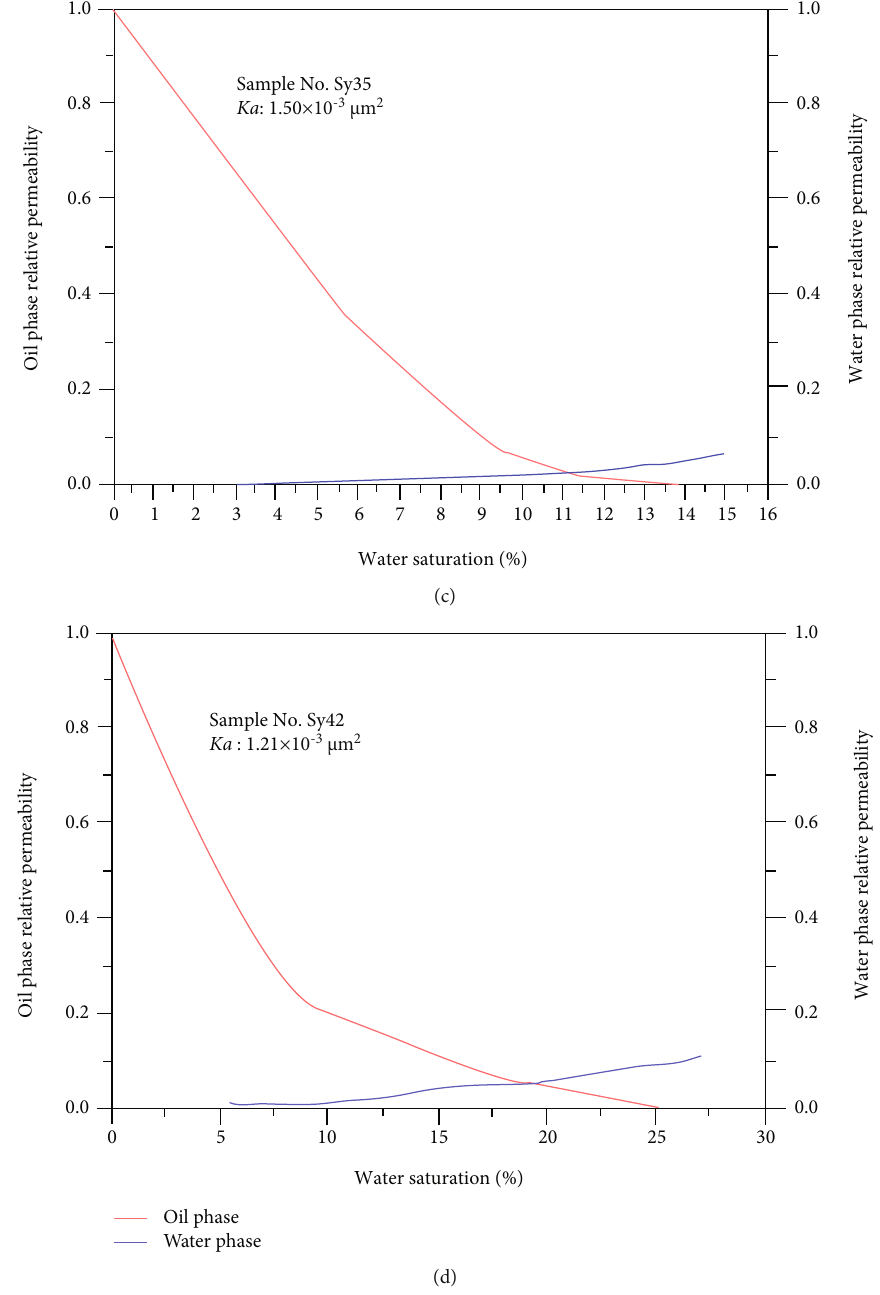
Figure 11: Oil-water relative permeability curve. Sy18 and Sy2 are fracture type, and Sy35 and Sy42 are matrix pore